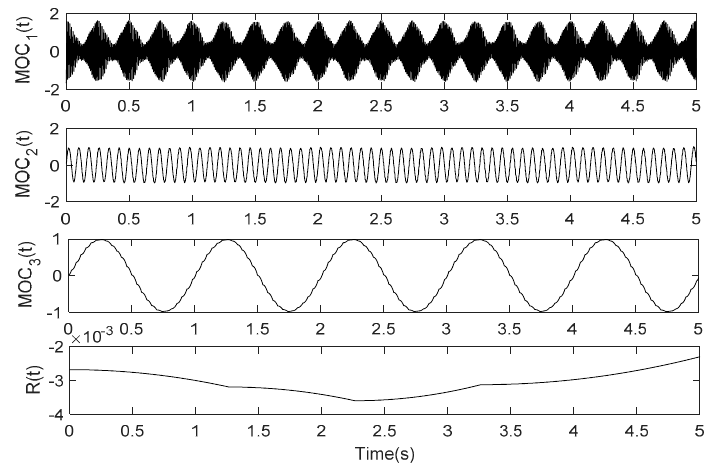
Figure 2. Local oscillatory-characteristic decomposition (LOD) results of the simulation signal x ( t ).